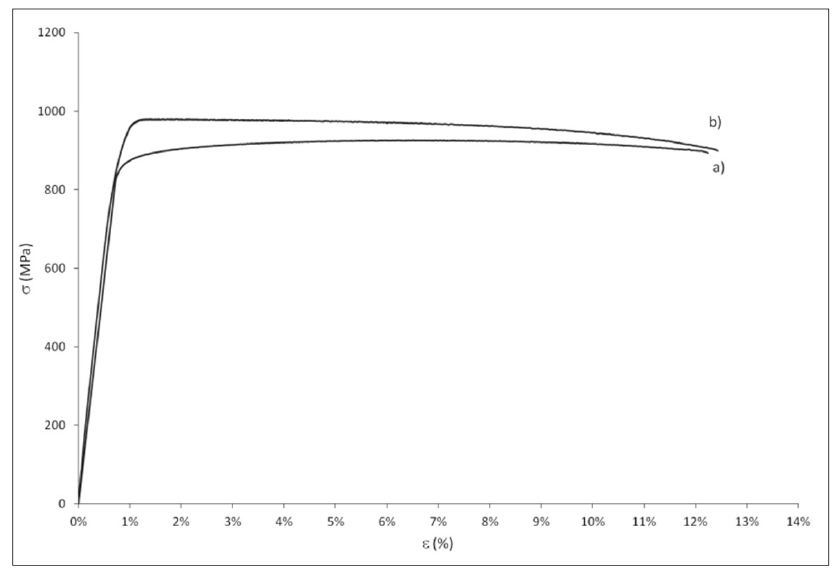
Figure 19. Stress–strain curves at room temperature for specimen B: ( a ) As-built specimen; ( b ) Machined specimen.